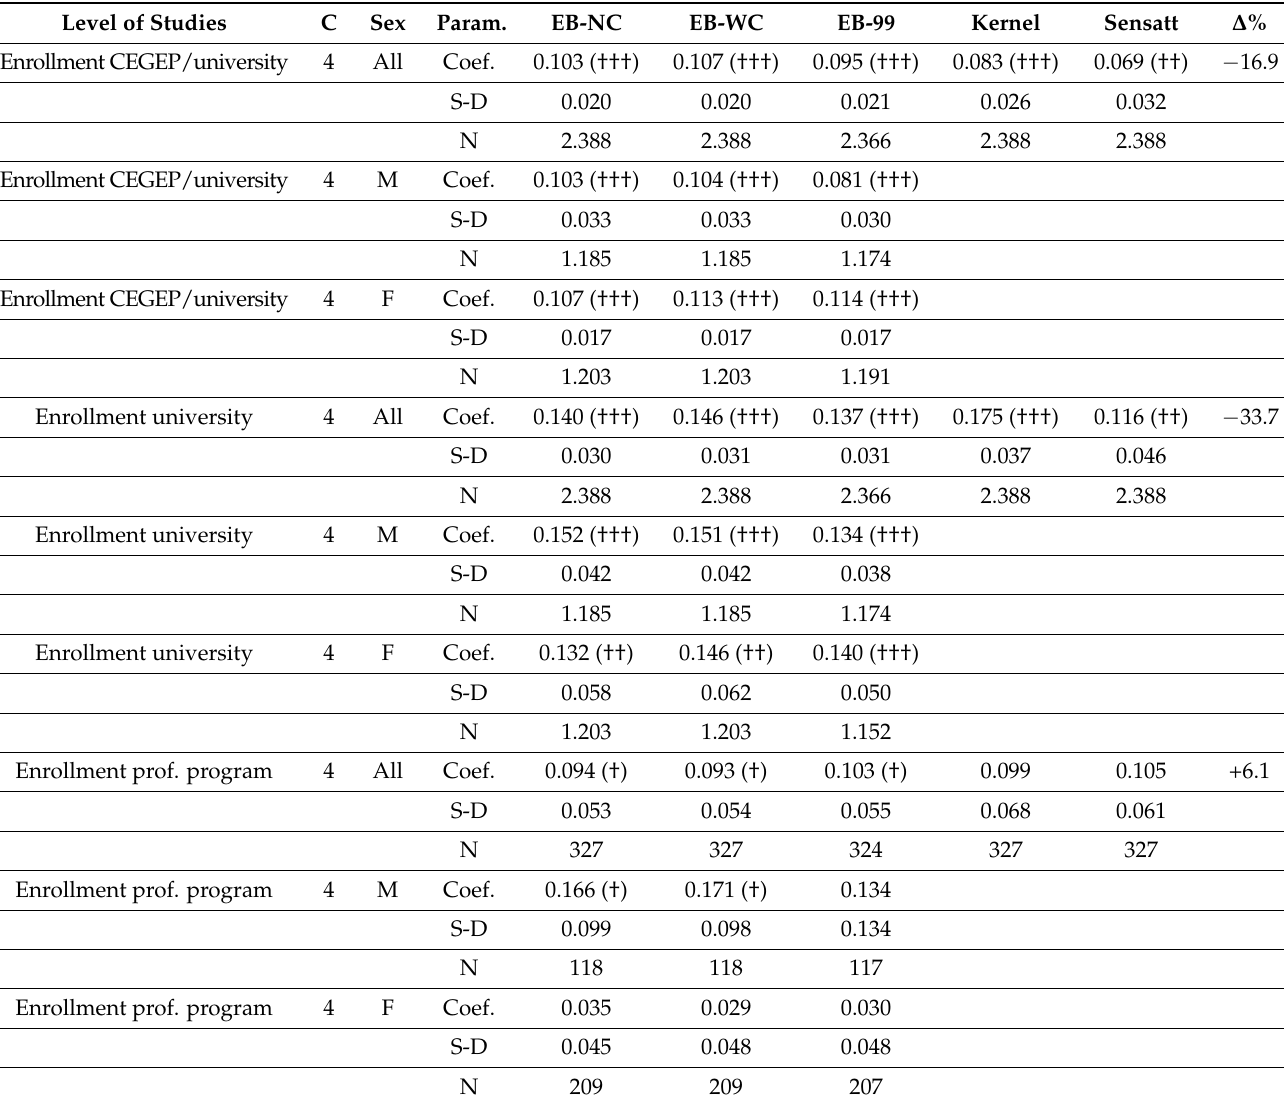
Table 5. Estimated effects of independent high school on CEGEP or university enrollment by sex and estimation methods, cohort A cycles 3 and